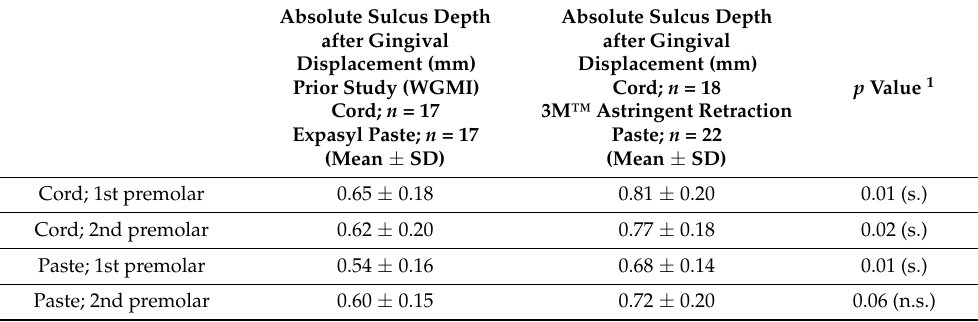
Table 3. Comparison of the absolute sulcus depth after gingival displacement between the prior study [6] and this study.